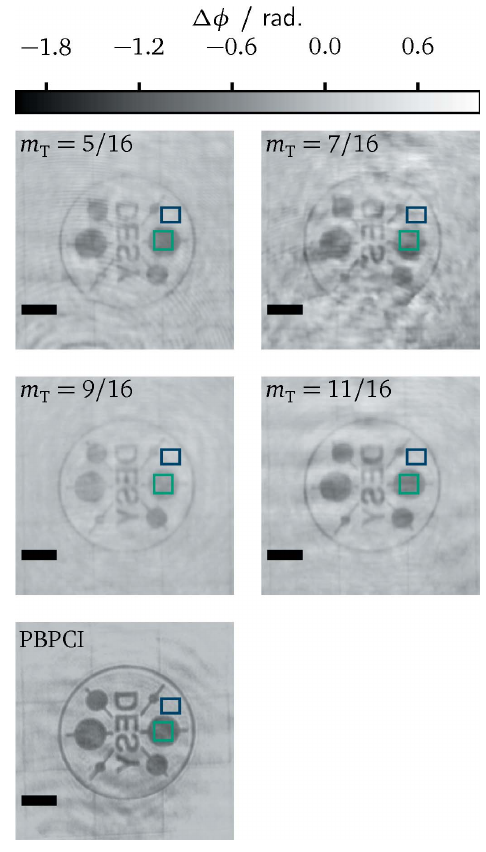
Figure 8 Phase reconstructions of the DESY-logo for different Talbot orders and for PBPCI. The regions used for the CNR evaluation are marked by the green and blue squares, respectively. The scale bar indicates 5 m m length in all panels.